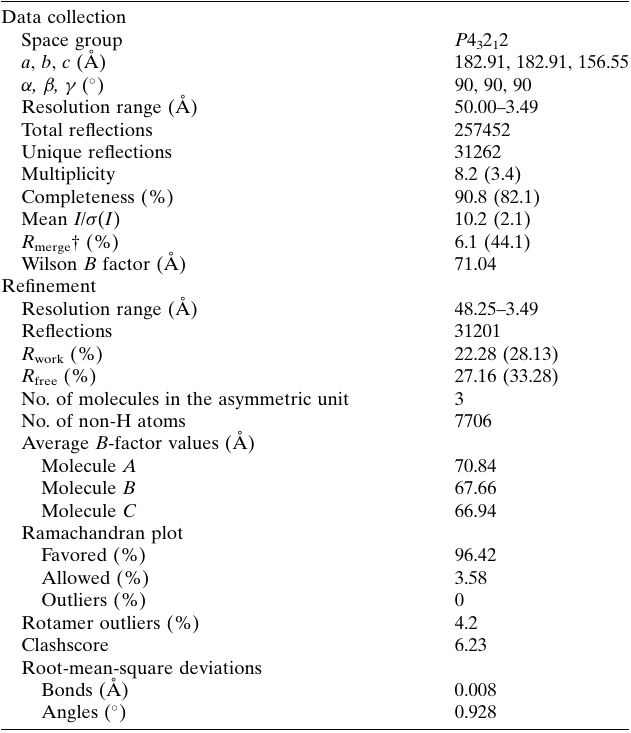
Table 1 Data-collection and refinement statistics. Values in parentheses are for the outermost resolution